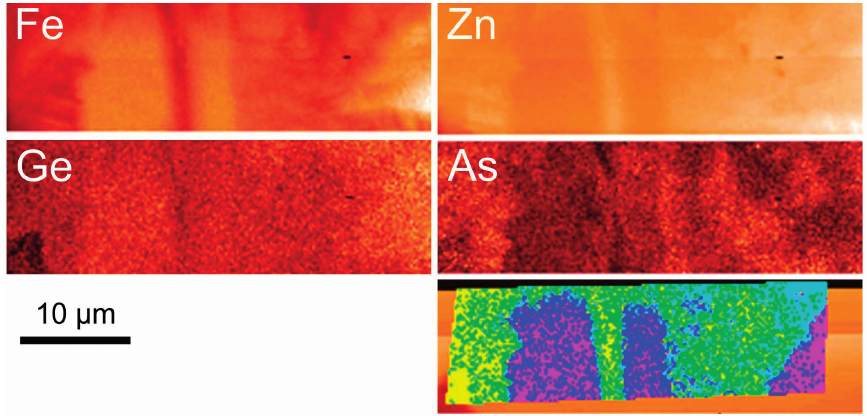
Figure 4. Microbeam X-ray Fluorescence element maps for Fe, Zn, Ge and As in a slice cut from Ge-Fe-rich area in the Tres Marias sphalerite (rectangle on Figure 2b). A 200 nm step size was used; which corresponded to the approximate beam size (Australian Synchrotron) and was also nearly identical to the smallest possible beam size. The maps show that the μ m-scale structures identified by FIB cross-section imaging are also expressed by compositional variation, i.e. , the darker, relict domains are Zn and As-poor but clearly Fe- and Ge-rich relative to the brighter domains. The map lower right is a composite of the Fe (red), Zn (green) and Ge (blue)